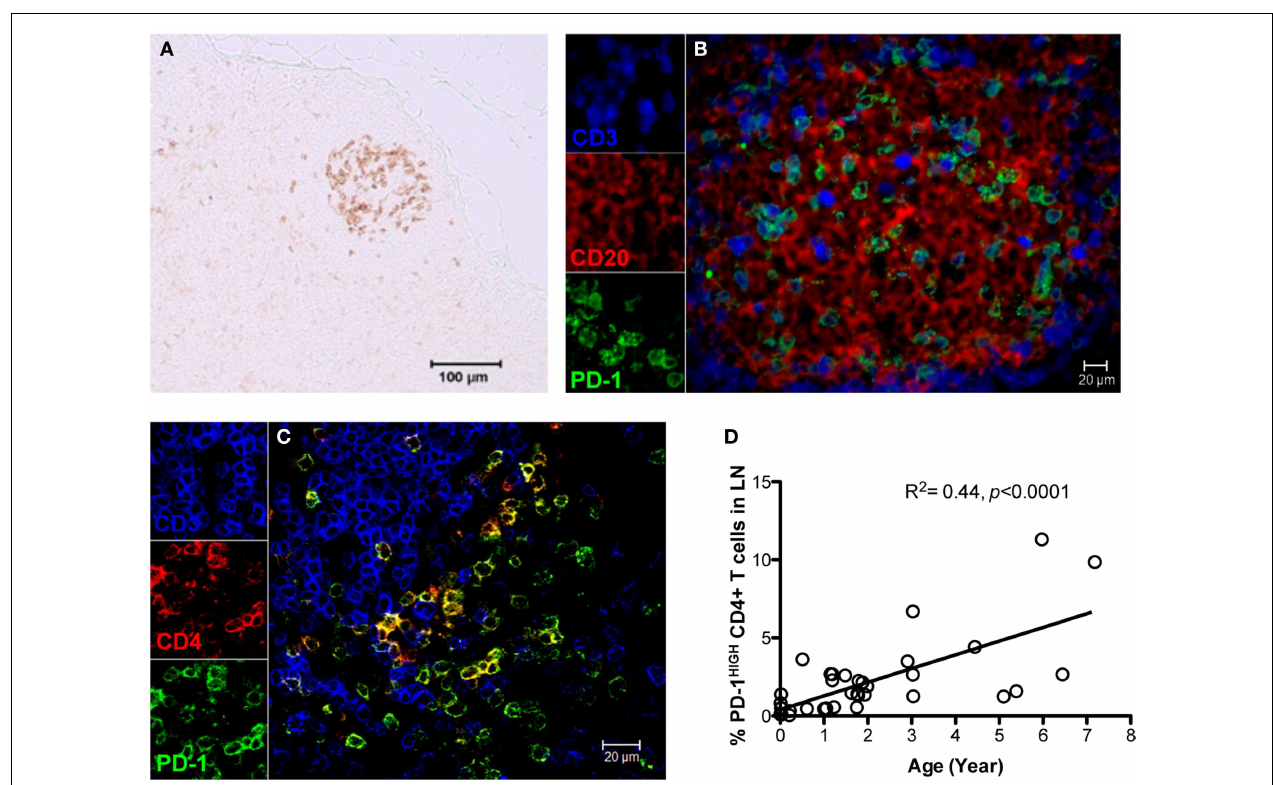
cells in GC of lymph nodes in adult animals. CD3, blue; PD-1, green; CD20 (B) or CD4 (C) , red. (D) Correlation of PD-1 HIGH CD4 + T cells with age in rhesus macaques ( R 2 = 0.44, p < 0.0001). PD-1 HIGH cells are specifically localized within GC and predominantly on CD4 + T cells. Scale bar, 100 µ m (A) or 20 µ m (B,C)